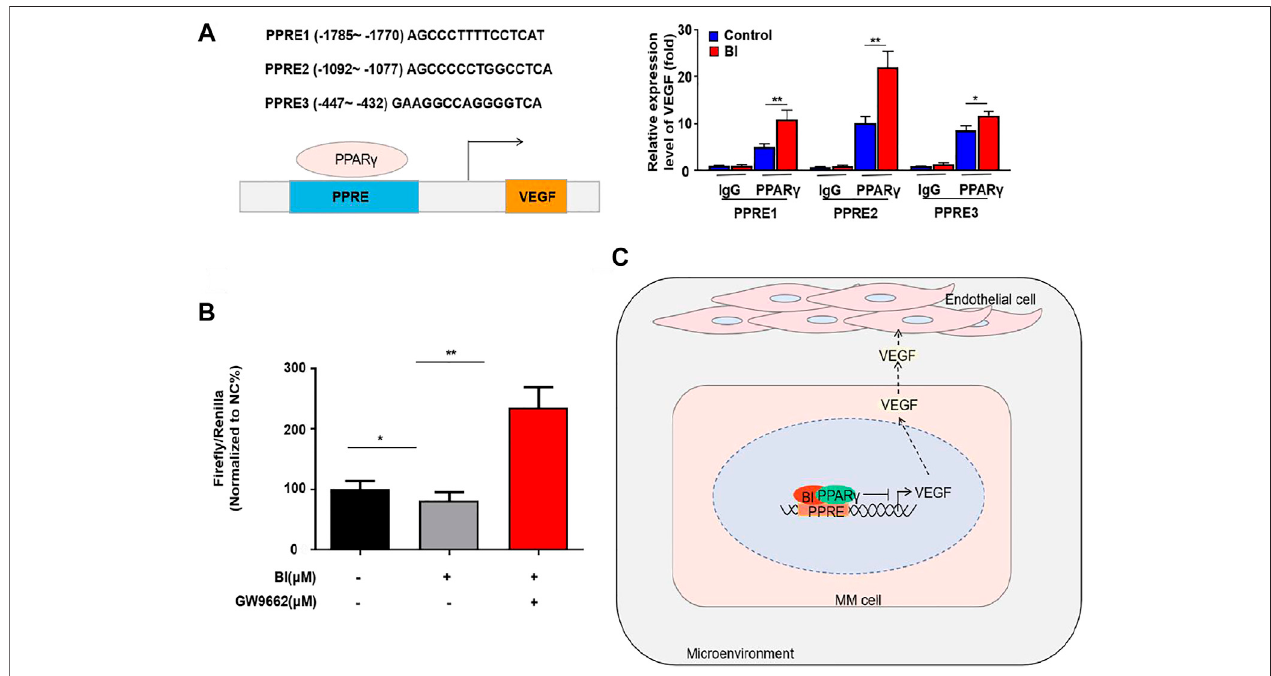
FIGURE 6 | BI enhanced the activation of PPAR γ . (A) ChIP assay detects the binding site of PPAR γ in the VEGF promoter region. (B) Luciferase reporter gene experiment detects the effect of BI and GW9662 on the transcriptional activity of PPAR γ . (C) Schematic model of the underlying mechanism of BI in MM. Abbreviations: BI, baohuoside I; PPAR γ , peroxisome proliferator – activated receptor γ ; PPRE, receptor responsive element; VEGF, vascular endothelial growth